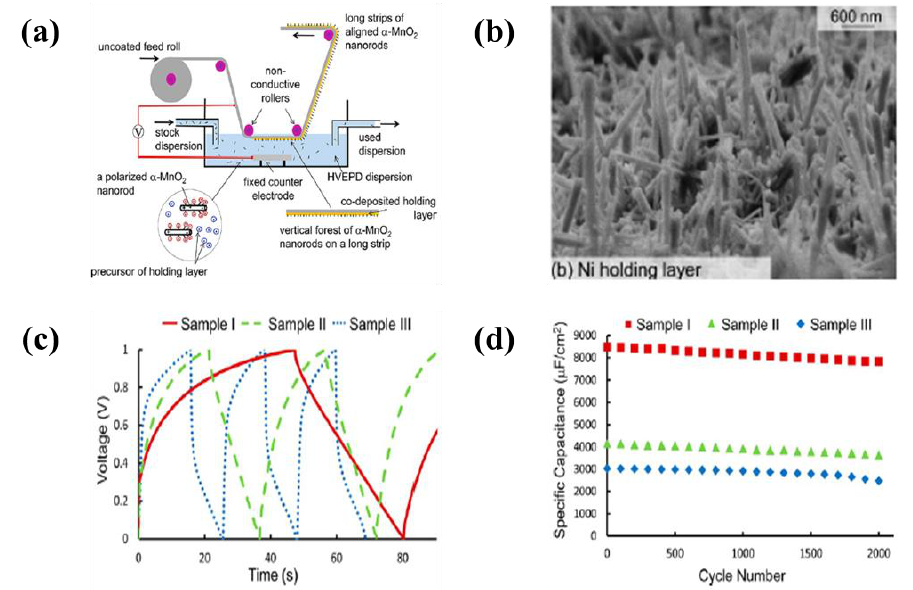
Figure 20. ( a ) Schematic and working mechanism of continuous HVEPD setup; ( b ) FE-SEM image of aligned nanoforests of α -MnO 2 nanorods with Ni holding layers; ( c ) Galvanostatic charge discharge curves at 0.25 mA · cm − 2 current for the three types of samples; ( d ) Decrease in the device capacitance over 2000 cycles for the three types of samples.